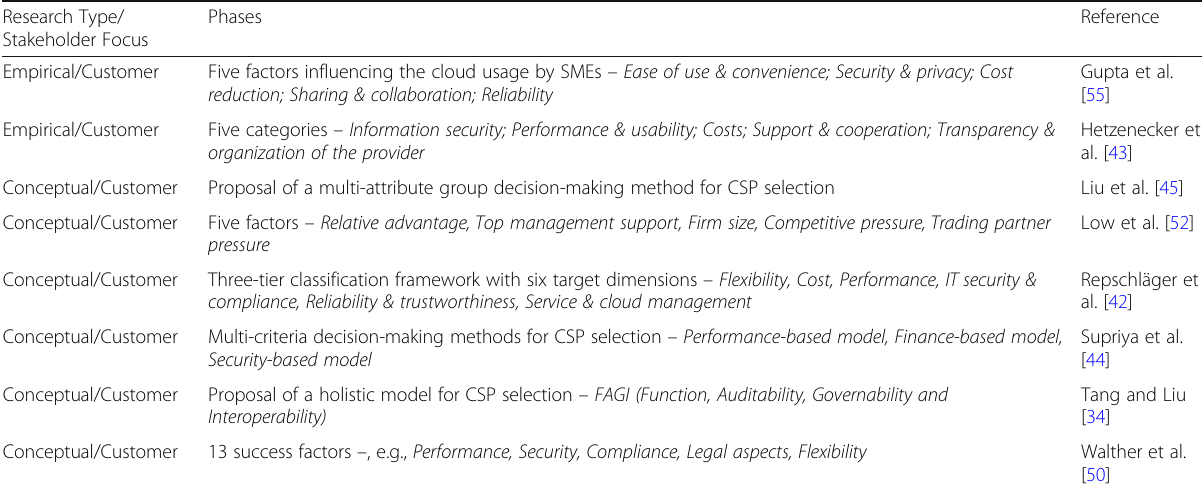
Table 1 Conceptual and empirical investigations for the selection of appropriate cloud services Research Type/ Stakeholder